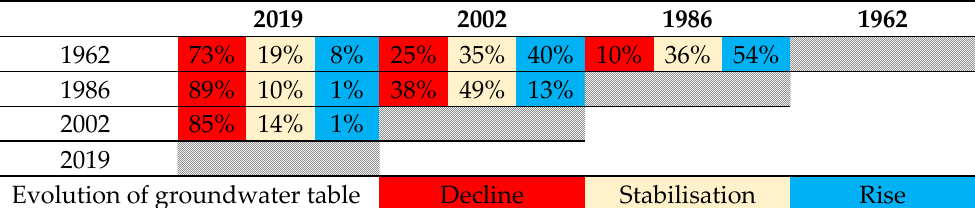
Table 1. Percentage of area concerned by decline, stabilisation or increase of water table between 1962 and 2019.